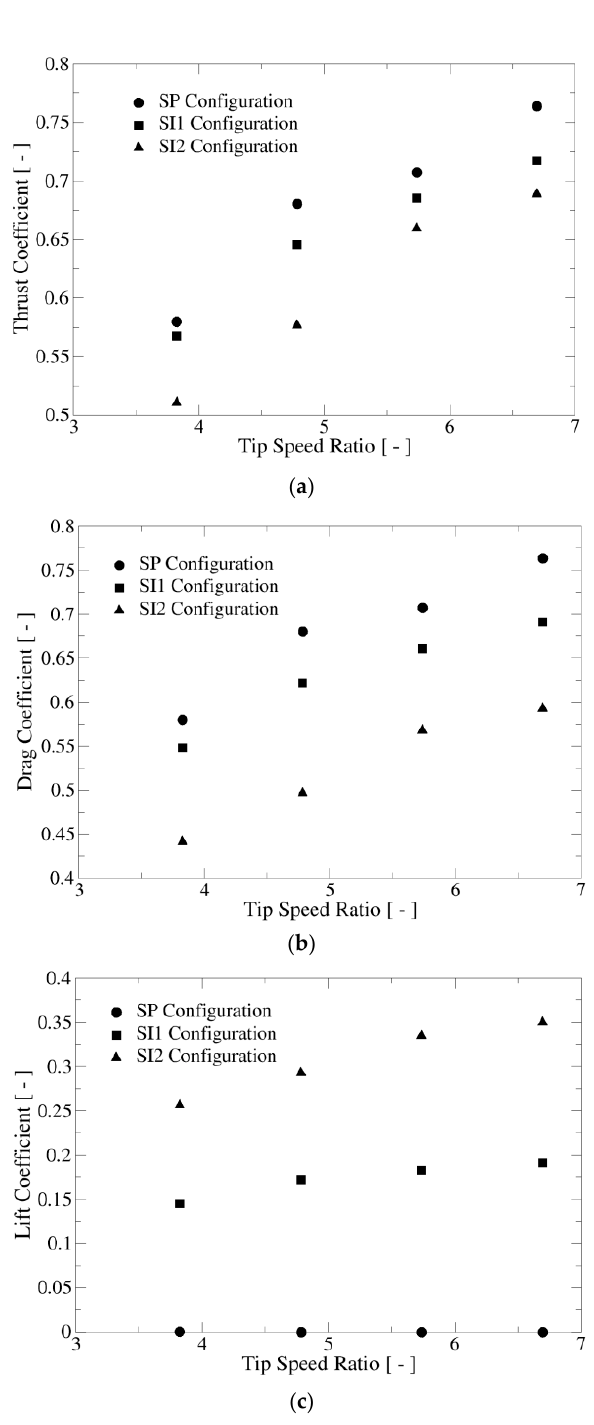
Figure 12. The force coefficient versus tip speed ratio for the different configurations: ( a ) thrust coefficient; ( b ) drag coefficient; ( c ) lift coefficient.